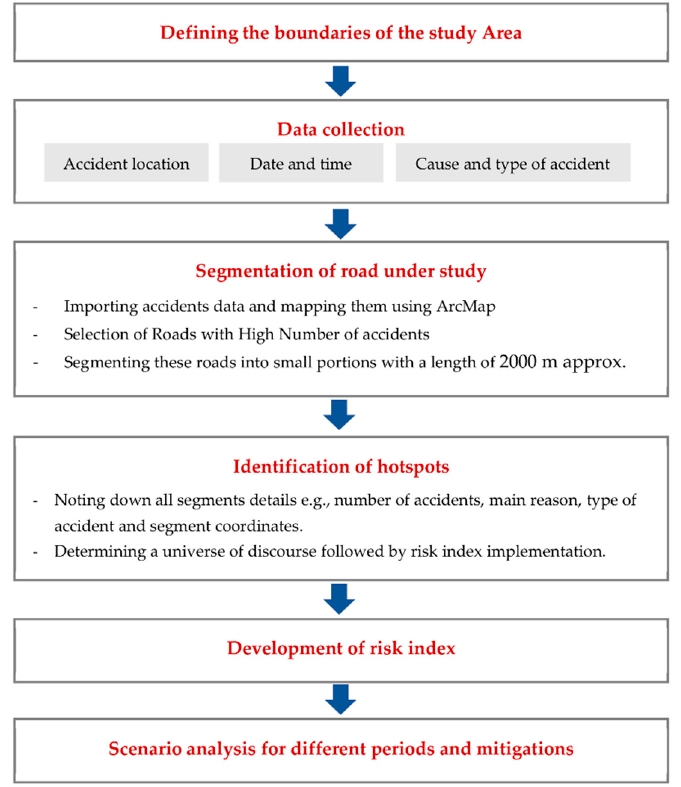
Figure 1. Traffic accident risk assessment framework .